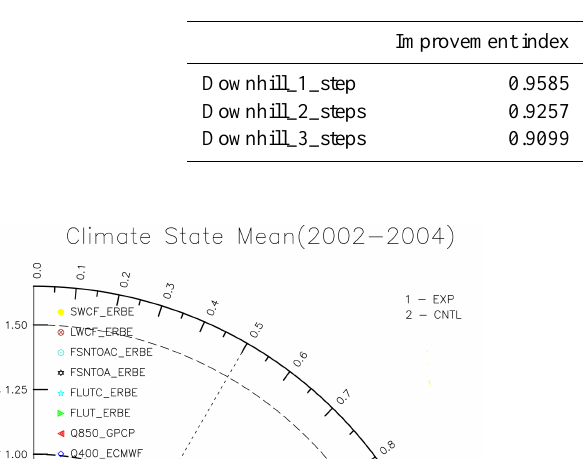
Table 4. The same as Table 3 but showing the comparison among the three downhill simplex methods.